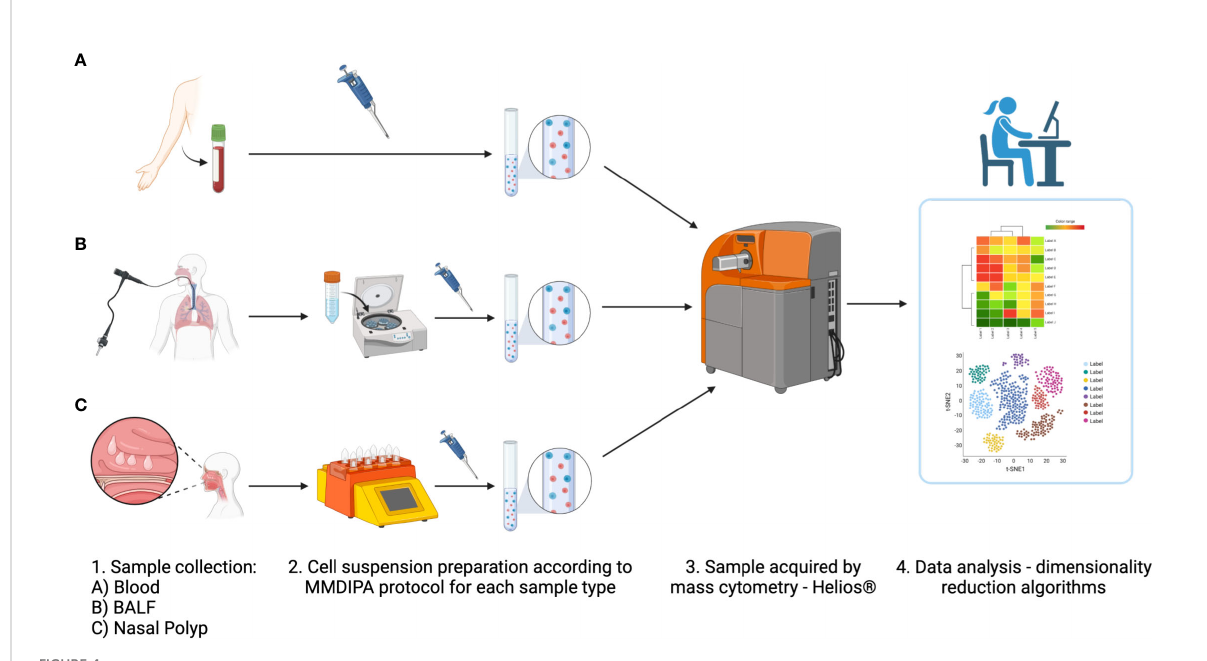
FIGURE 4 Overview of modi fi ed labeling protocol with Maxpar Direct Immune Pro fi ling Assay (MDIPA) panel for mass cytometry (MMDIPA) using human (A) blood, (B) bronchoalveolar lavage fl uid (BALF), and (C) nasal polyp. (1) After collection, (2) samples were worked up following the MMDIPA protocol established. (3) The obtained single cell suspensions were acquired in a Helios ® (Standard BioTools), and (4) the data were analysed using selected softwares ( fi gure created with